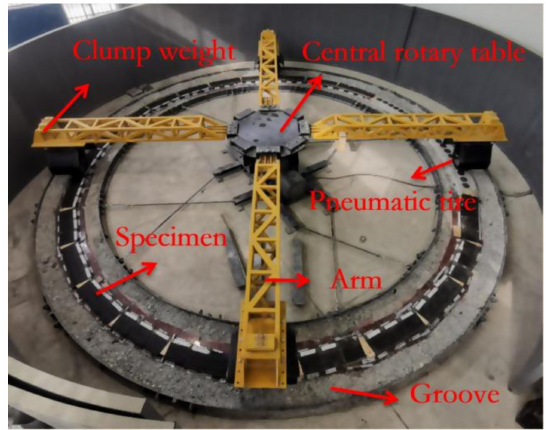
Figure 4. Circular vehicle simulator (CVS)